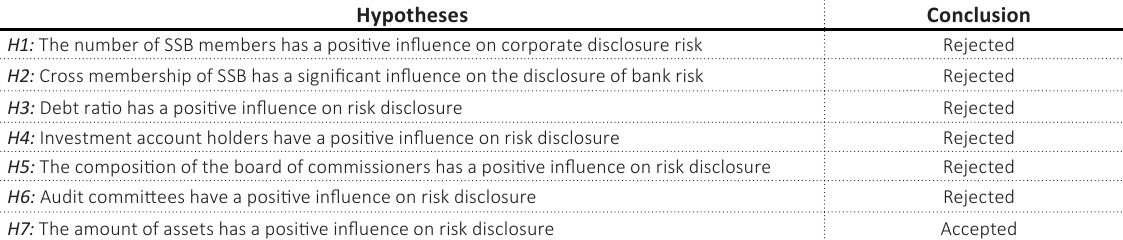
Table 4. Hypothesis acceptance and rejection